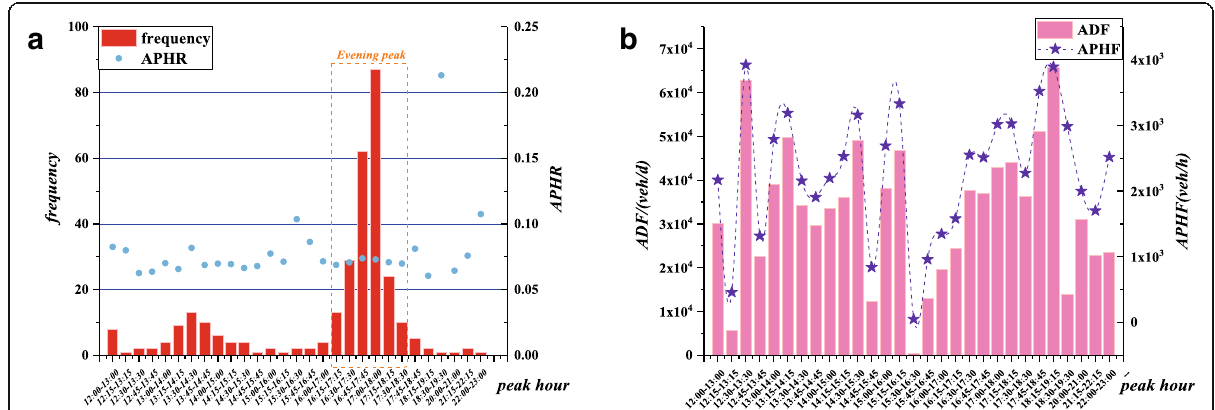
Fig. 7 Evening peak time characteristics, ( a ) peak hour distribution and APHR; ( b ) correlation between average peak hour flow and average daily total